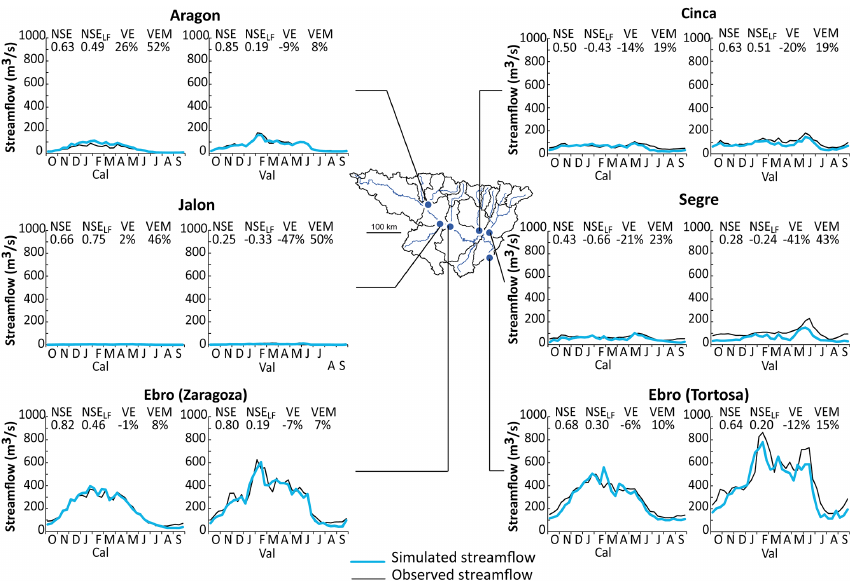
Figure 8. Simulation of influenced streamflow in the Ebro Basin from 1971 to 2009: results for the periods over which simulations of natural streamflow were calibrated (Cal: 1981–2009) and validated (Val: 1971–1980). Optimal values of NSE, NSE LF , VE, and VEM are 1, 1, 0 and 0,